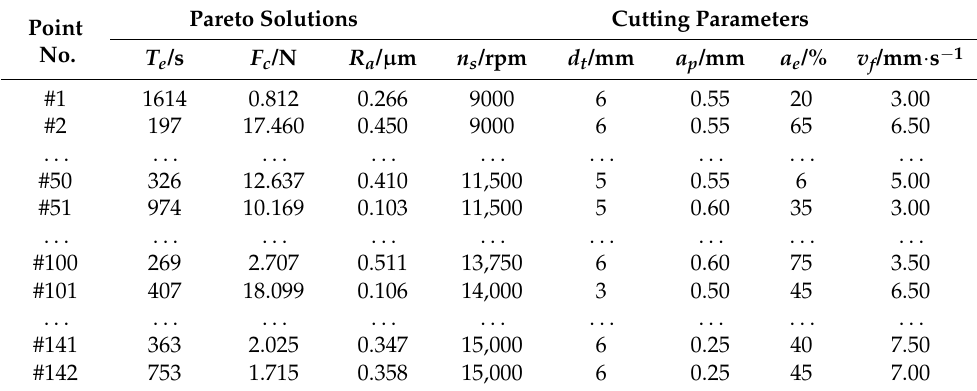
Table 6. Pareto solutions and corresponding cutting parameters.